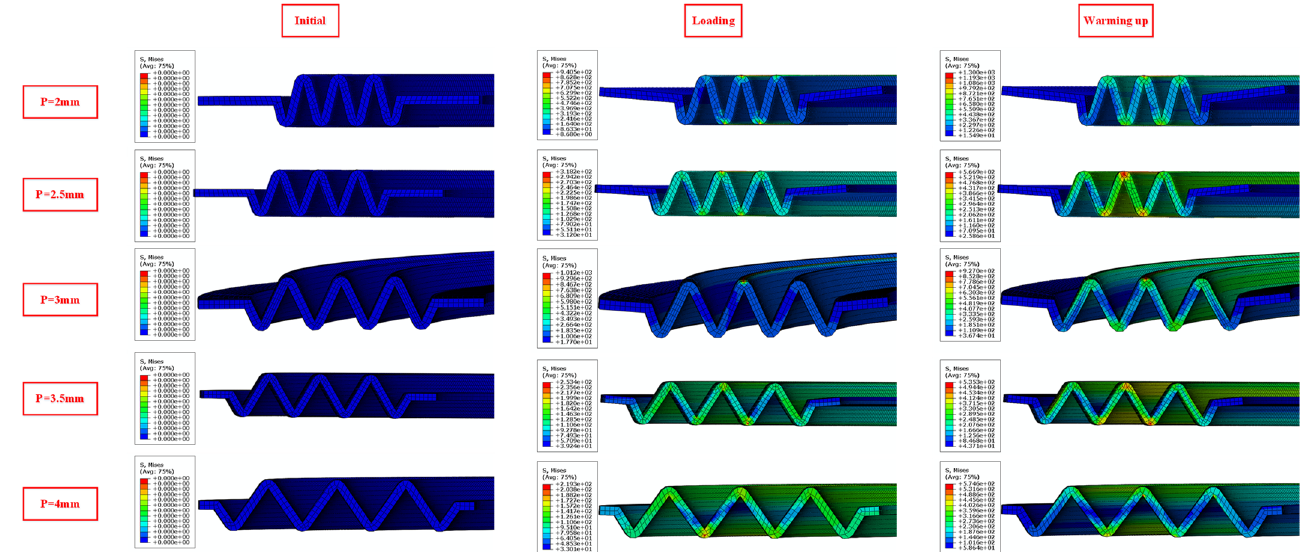
Figure 16. Deformation contours of NiTi alloy corrugated gasket with different corrugation pitches.